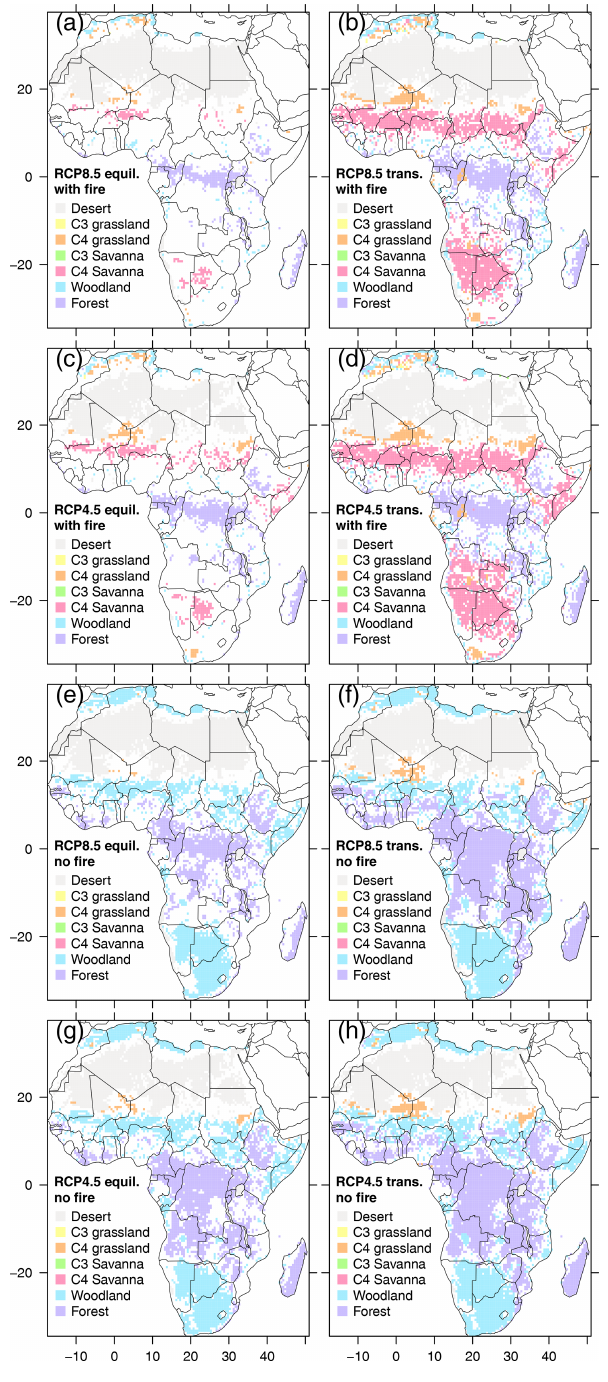
Figure 8. Areas with only one biome type in all 13 decades (i.e., biome core areas) shown for each of the 8 scenarios. Areas that experience one or more biome transitions are masked out (white areas). Transient scenarios are indicated by label “trans.” (b, d, f, h) , equilibrium scenarios by label “equil.” (a, c, e, g)